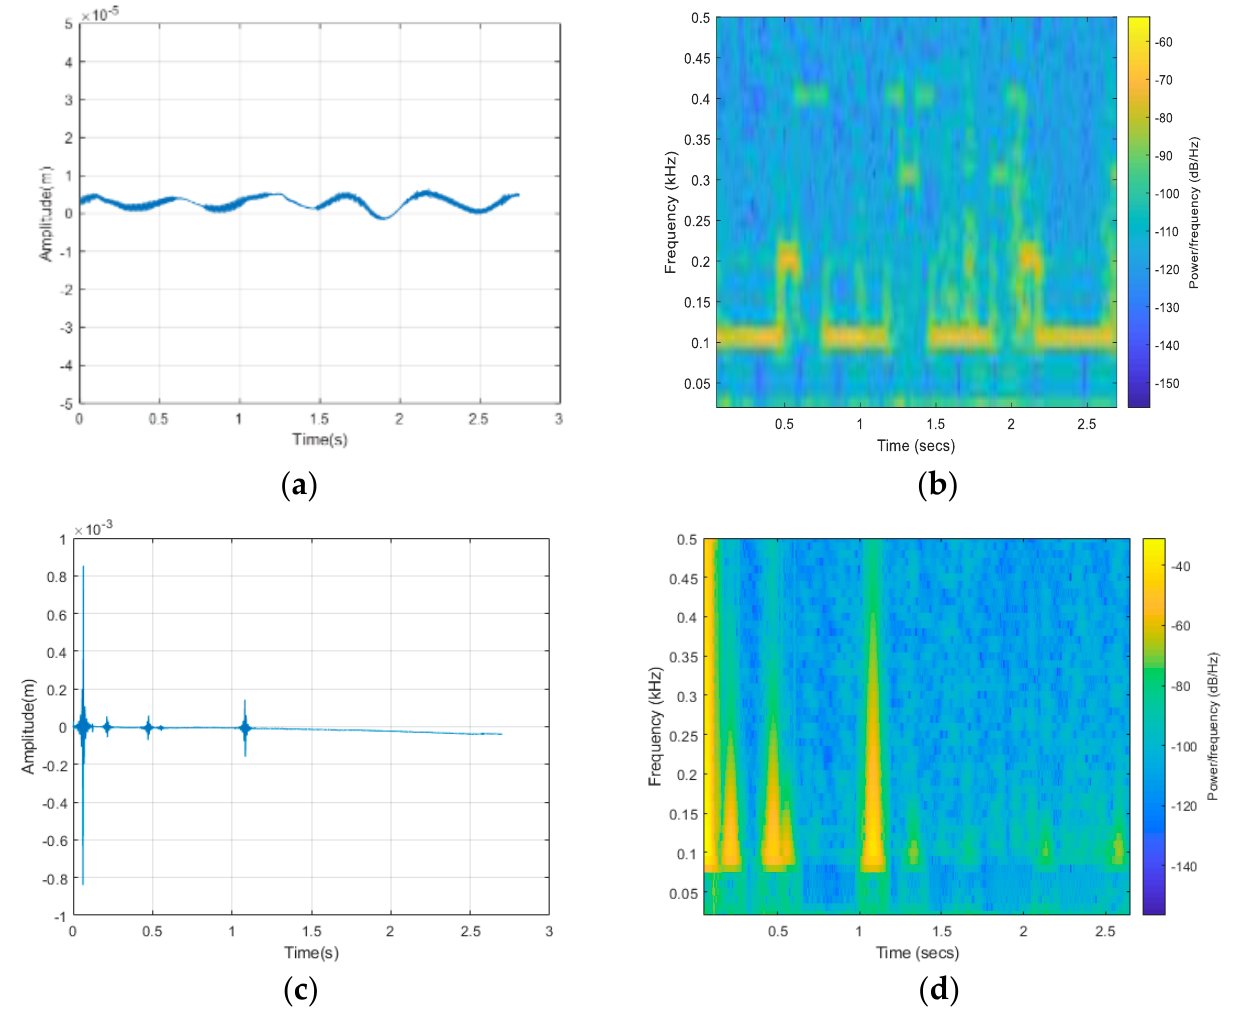
Figure 8. ( a ) The proposed algorithm’s result (strong wind); ( b ) time–frequency result; ( c ) proposed algorithm’s result (strong wind); ( d ) time–frequency result.